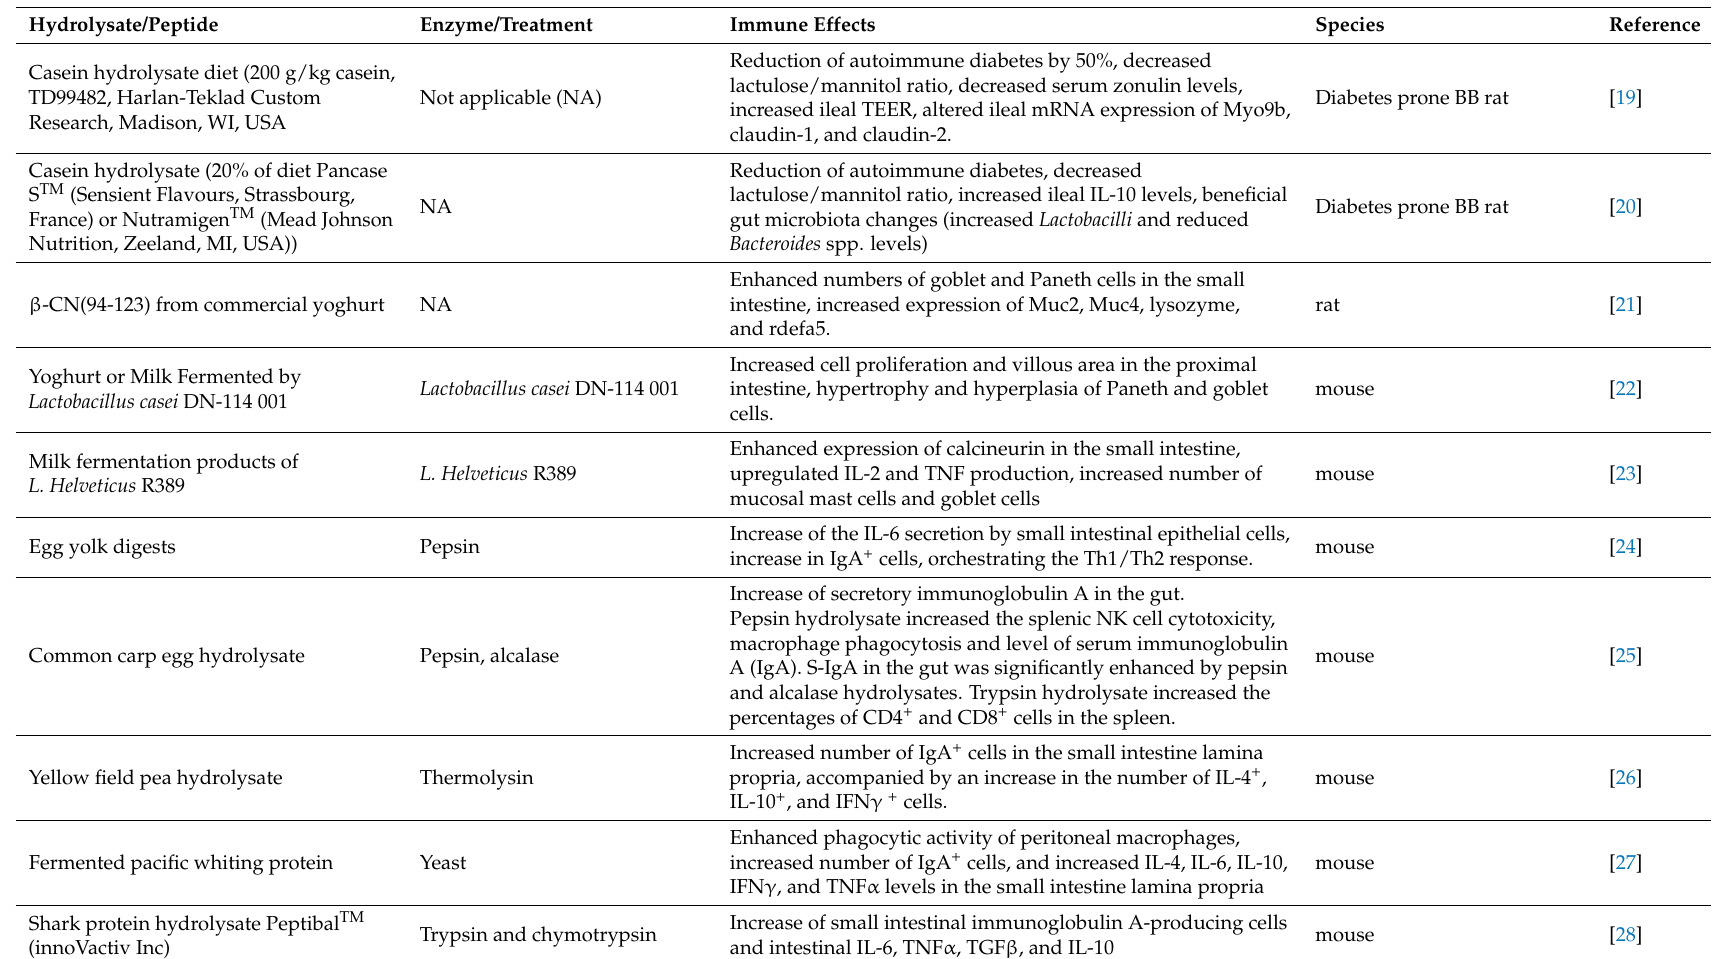
Table 1. Overview of hydrolysates and their immune